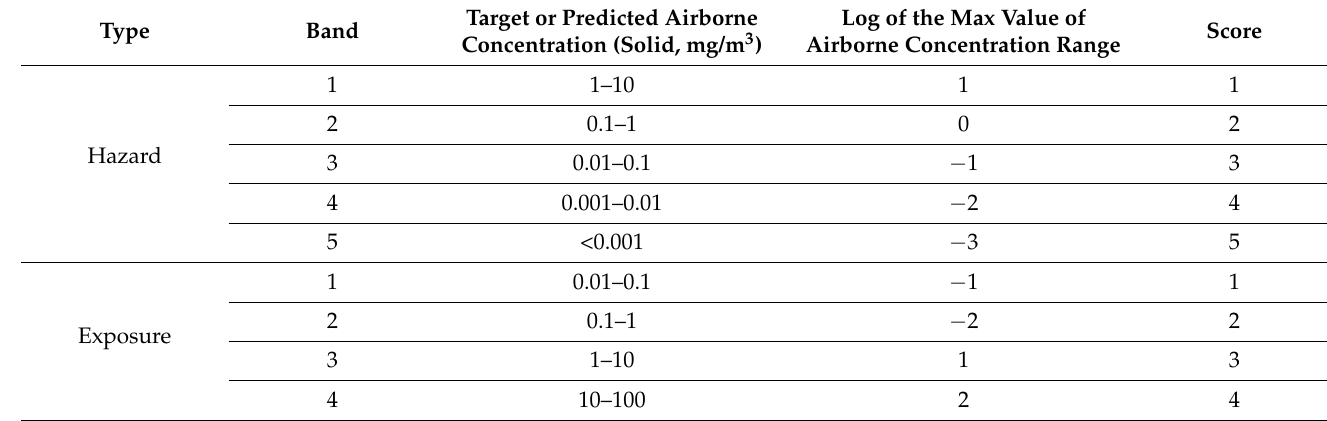
Table 4. Allocation of hazard and exposure bands to hazard and exposure scores.